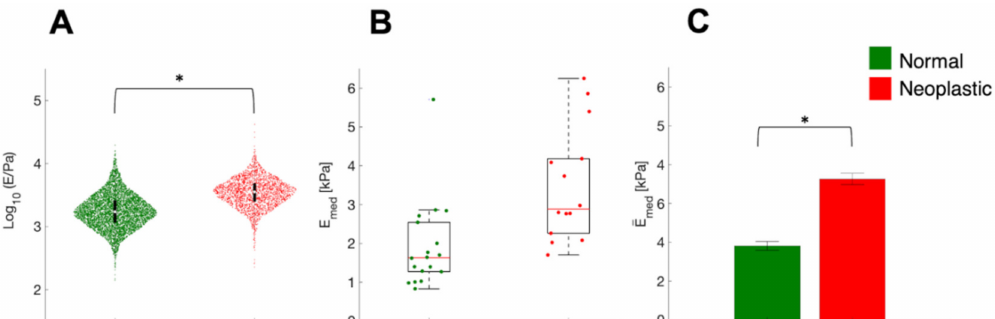
Figure 4. The stiffening of ECM in CRCPM samples. ( A ) Logarithmic values of the YM and their distribution in normal and neoplastic ECM samples obtained from one patient. Violin plots were plotted collecting YM values from all single FCs. Violin plots suggest that the distribution of local YM values is approximately lognormal. The circle and the black bars represent the median and the interval between 25th and 75th percentiles. ( B ) Comparison of median YM values E med from each force volume in linear scale for normal and neoplastic samples from one patient. The red line represents the median value, the box encloses the interval between 25th and 75th percentiles of the sample. Whiskers go from the upper and lower limits of the interquartile range to the furthest observations, within 1.5 × the interquartile range; data points beyond this limit are considered outliers. ( C ) Comparison of the mean median YM values for the two conditions tested. In (A, C), * means p <